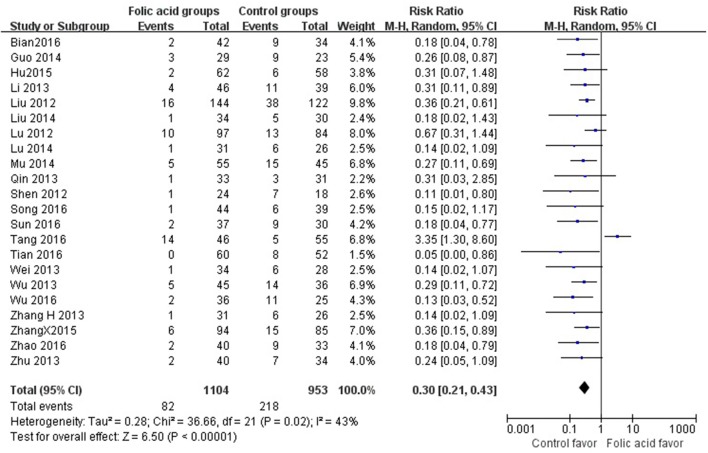
Pooled estimate of decrement in cardiovascular and cerebrovascular events (CVCE).